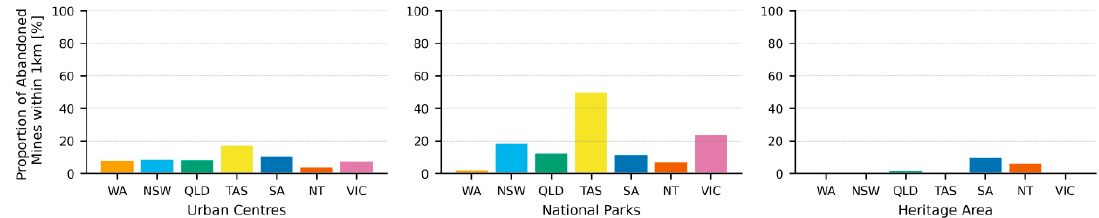
Figure 5. State-by-state breakdown of abandoned mines located within 1 km of urban areas, national parks, national heritage and Indigenous heritage areas.